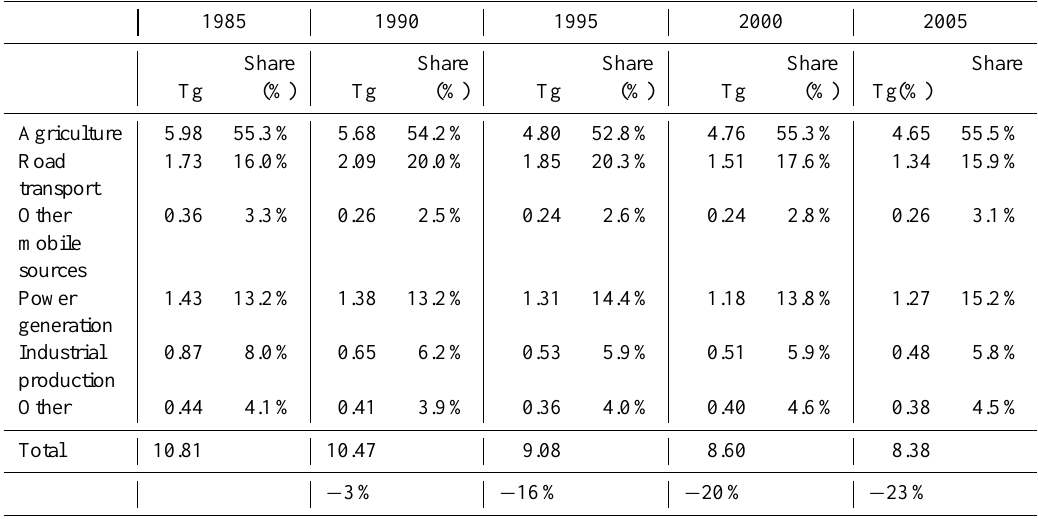
Table 1. Comparison of European emissions of N r in Tg, using the nitrogen content of both NH 3 and NO x to analyse the overall trend development of N r release into the atmosphere. Emission figures based on the EDGAR ∗ emission inventory, 4.2.